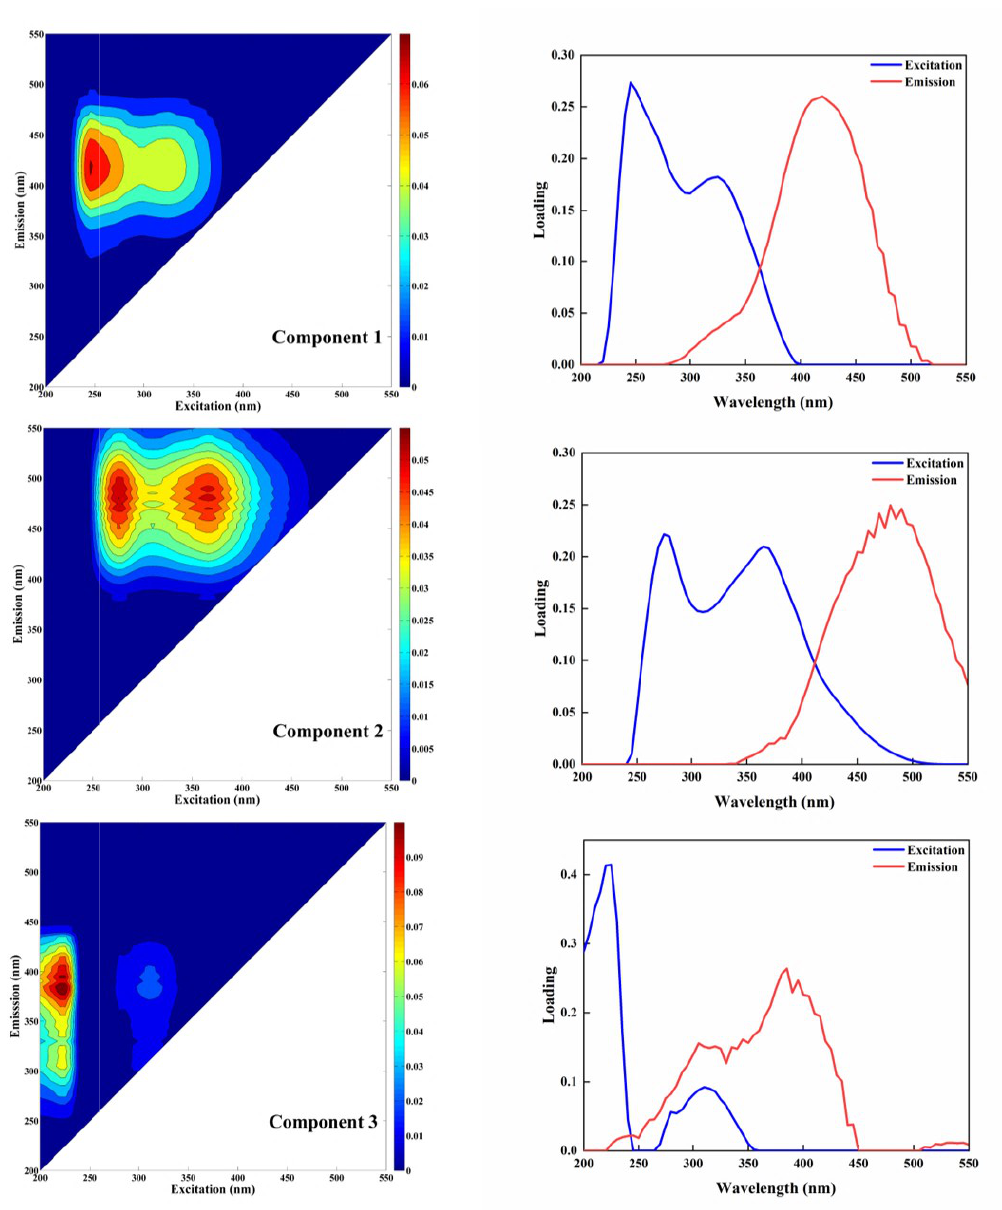
Figure 4. PARAFAC model A. Spectral characteristic EEM images of fluorescent components identi- fied using EEM-PARAFAC analysis of temperate forest soil